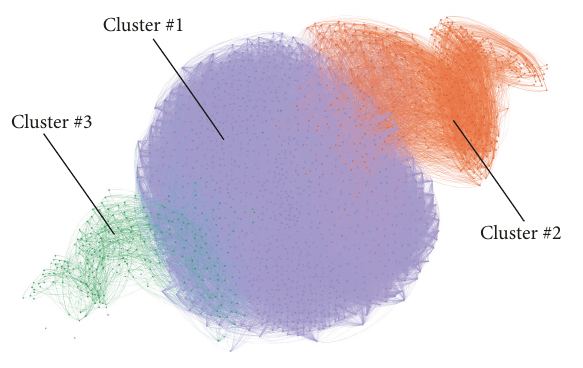
Figure 14: Graph-based representation of processes’ space for three clusters in social media